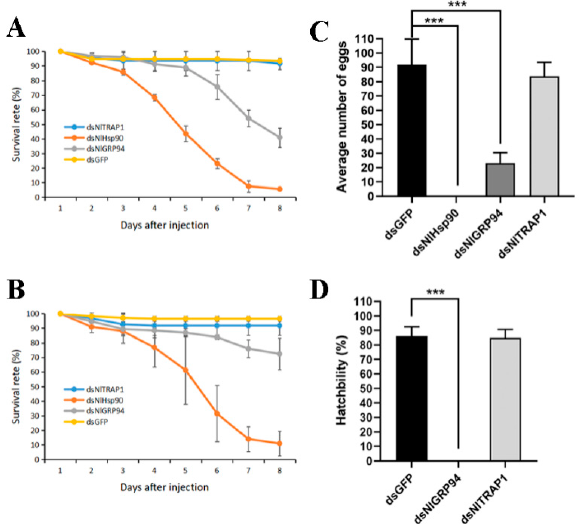
Figure 5. E ff ects of dsRNA treatments on nymph survival and female fecundity. ( A ) The survival rate of BPH 8 days after RNAi when 2nd instar nymphs were injected with dsRNA. ds GFP was used as the negative control in each group, n = 100. Three biological replicates were performed (data are shown as means ± SEM). ( B ) The survival rate of BPH eight days after RNAi when 4th instar nymphs were injected with dsRNA. ( C ) Average number of eggs laid by each female after di ff erent RNAi treatments. ( D ) Egg hatchability after RNAi treatment. Ten repetitions were performed. The results are shown as the mean ± SEM. *** p < 0.001 (Student’s t